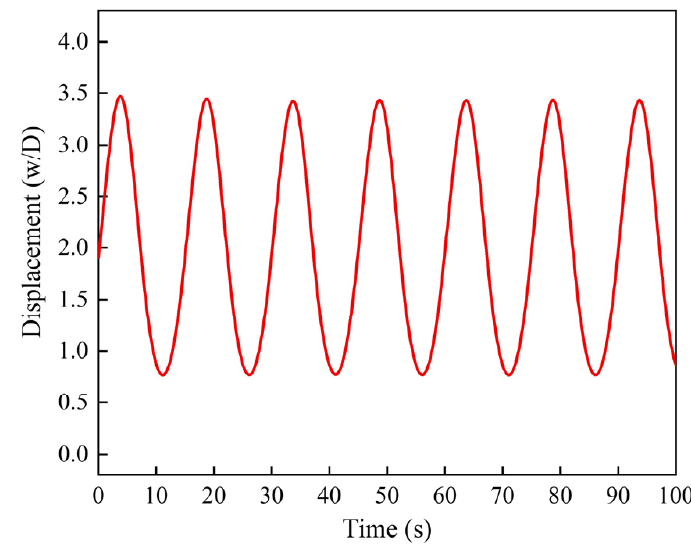
Figure 18. Displacement oscillation history of point P.